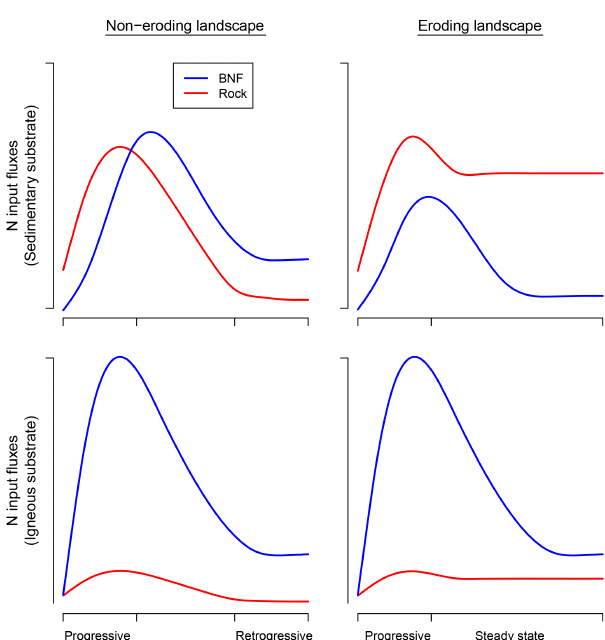
Figure 7. Conceptual diagram of interacting state-factor controls (organism, parent material, topography, time) on terrestrial N inputs (biological N fixation (BNF) and rock weathering). Our synthesis points to sustained and ecologically significant rock N inputs among eroding landscapes with high N parent material (e.g., fine-grained sedimentary rocks). Among non-eroding landscapes, rock N inputs may be high when fresh bedrock is exposed but otherwise comprise a small faction of the long-term N